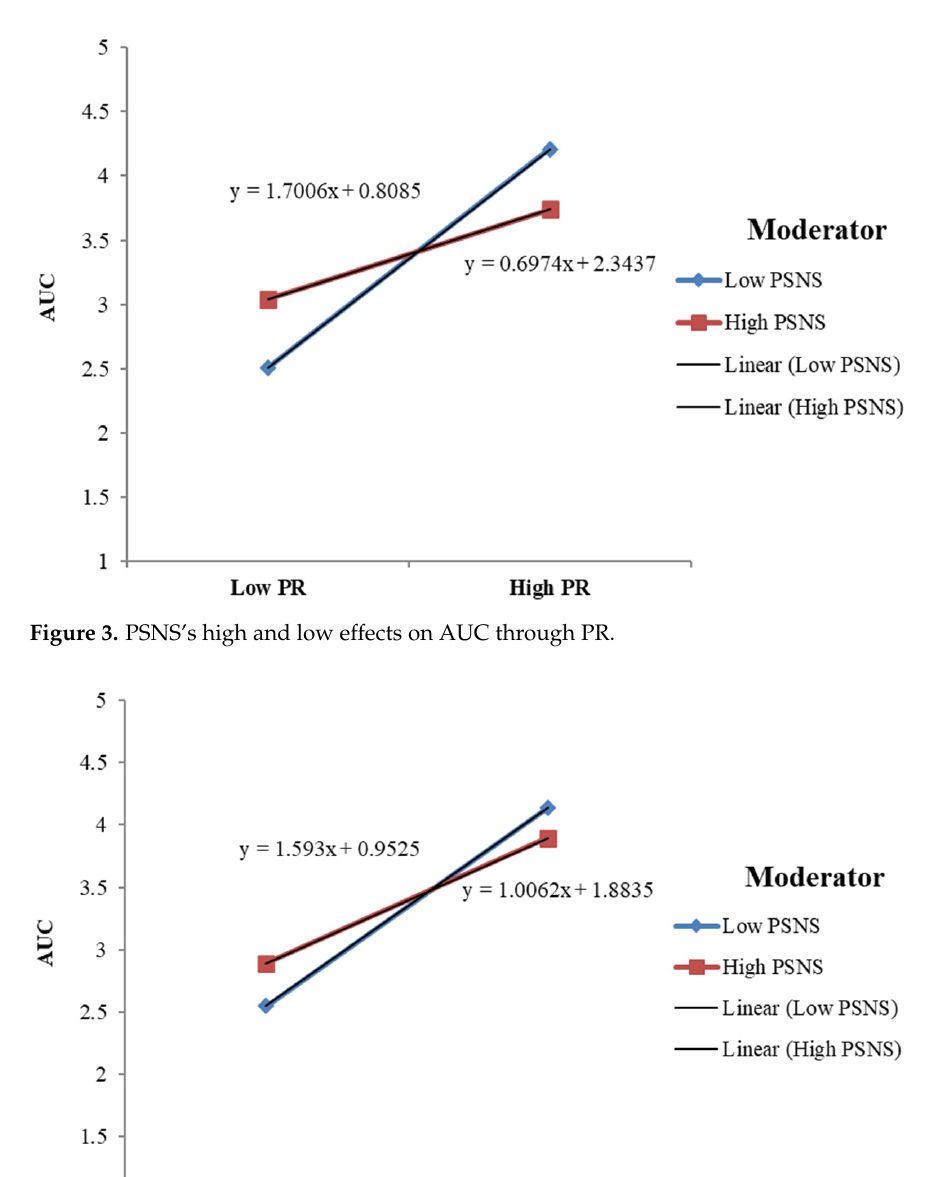
Figure 2. PSNS’s high and low effects on AUC through PT.